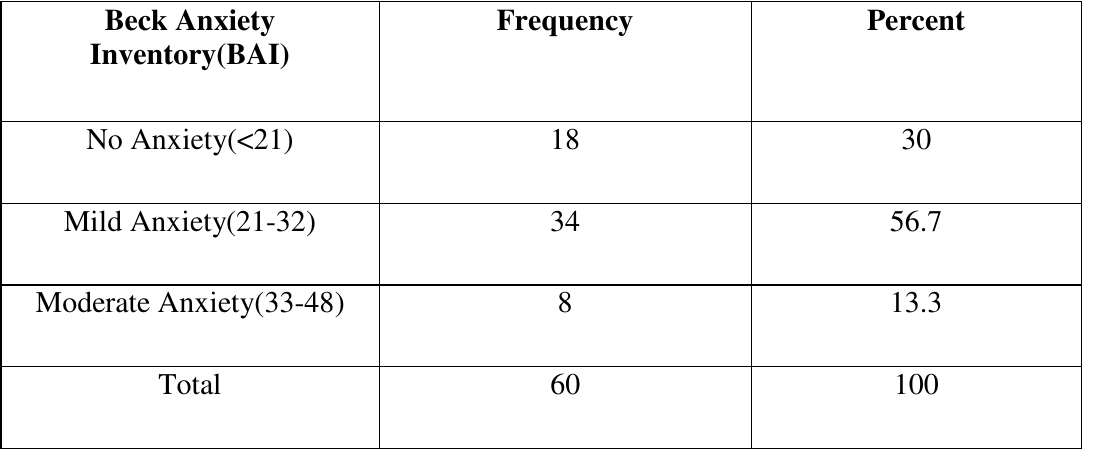
Table: 2. Distribution of Respondents According to Different Levels of Weighted Score